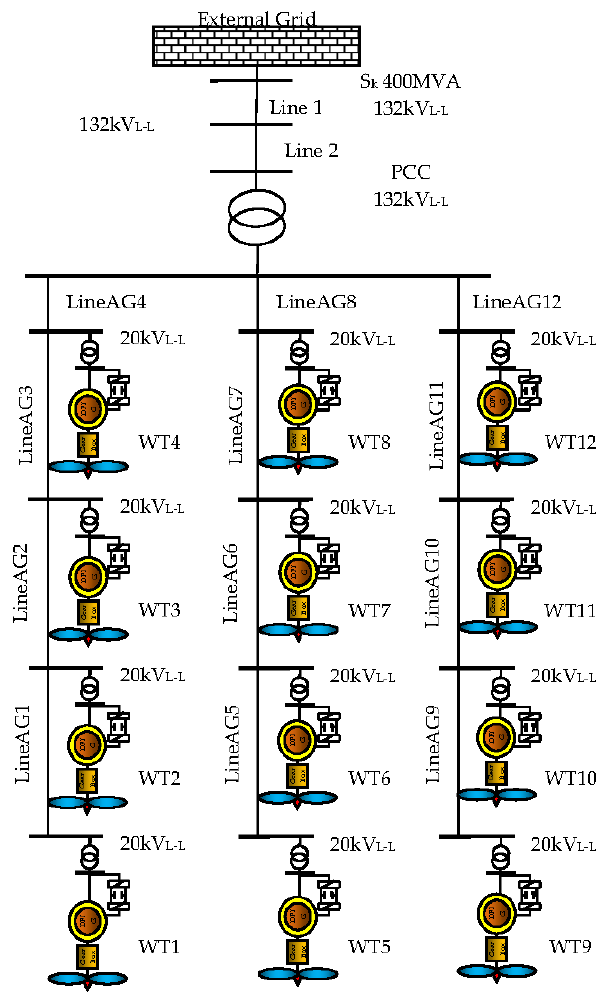
Figure 8. Structure of the tested wind farm.